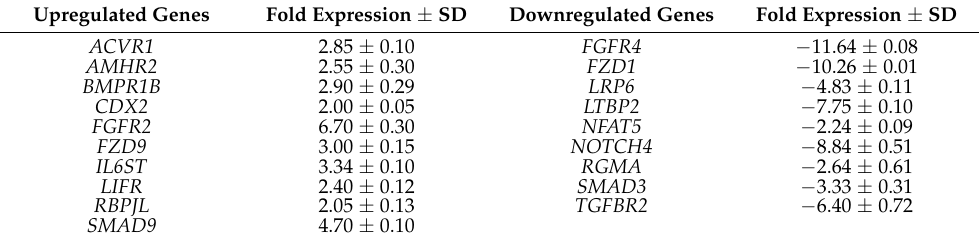
Table 6. Analysis of stem cell signaling pathway in MES-like GSC#83 during differentiation. Upregulated Genes Fold Expression ± SD Downregulated